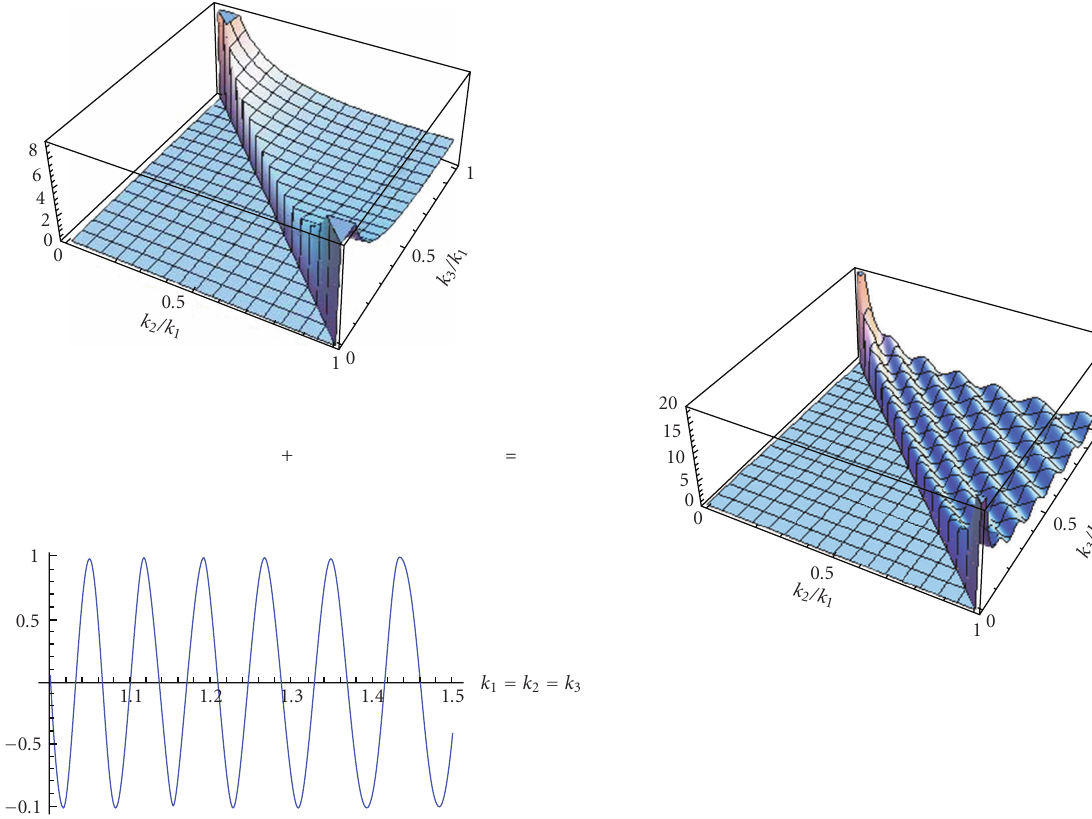
Figure 18: A mixing of an intermediate shape [ ν = 7 / 6 in (174)] and a resonant running